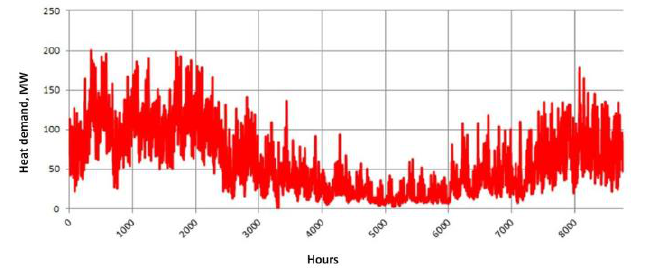
Fig. 1. Course of the Heat Demand within the DH system modelled